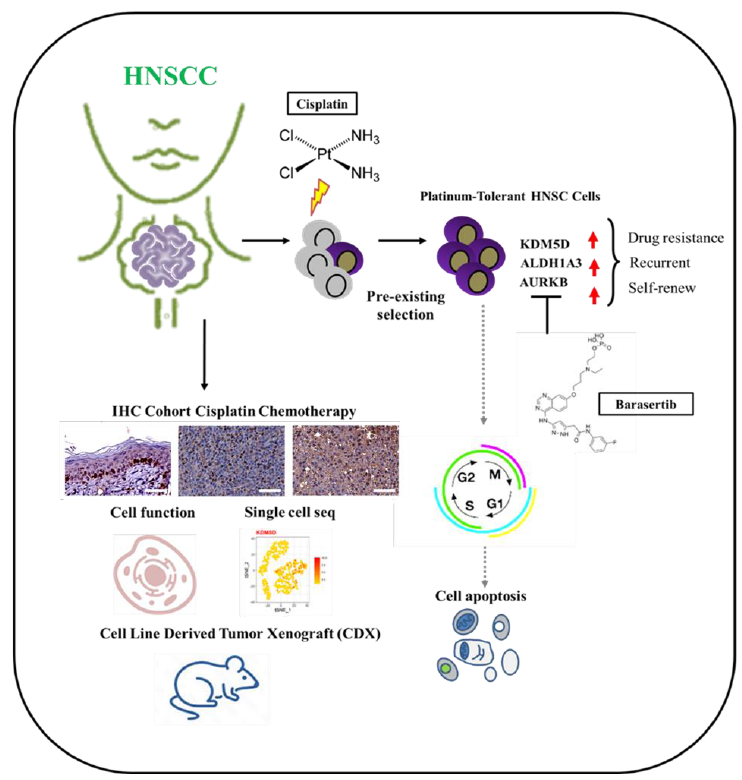
Figure 8. Schematic illustration of KDM5D contribution to affect the clinical outcome and biological development of platinum-tolerant persister cells in HNSCC. Left panel schema shows association between high KDM5D expression and poor clinical outcome in HNSCC patients encompassing poor response to platinum treatment or early recurrence disease. Right panel schema illustrates development of platinum-tolerant persister cells characterized by high expression of KDM5D / AURKB axis which disrupts AURKB by barasertib treatment deregulated tolerance mechanism and promoted mitotic catastrophe in platinum-tolerant